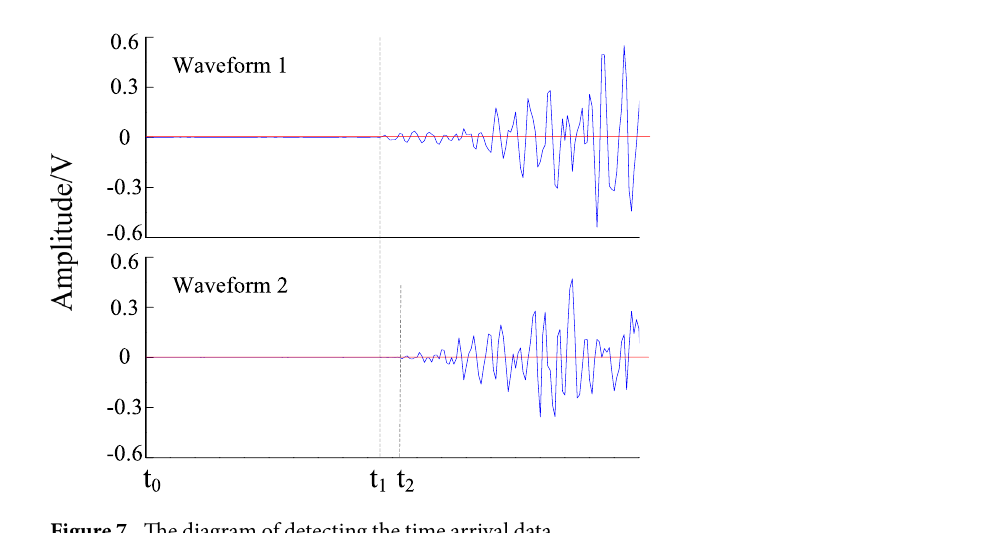
Figure 7. The diagram of detecting the time arrival